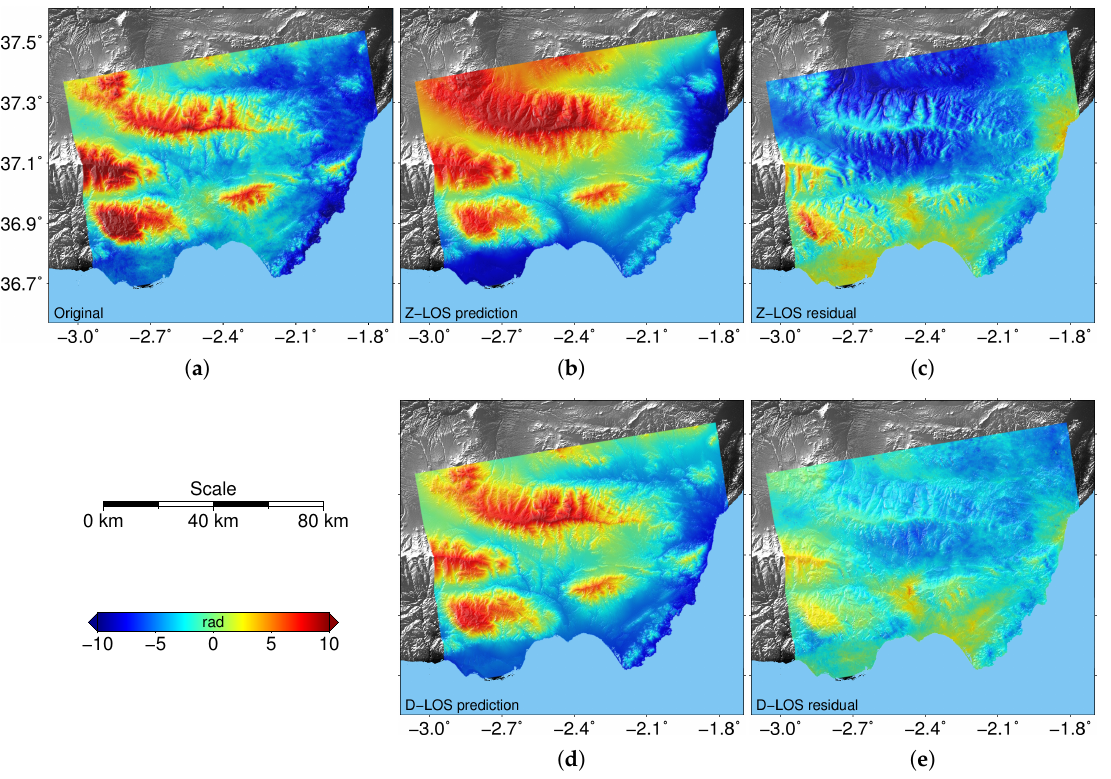
Figure 13. 20171031–20171124 (Ifg11) case study of APS compensation in Almería. ( a ) The original interferogram. ( b , c ) The Z-LOS predicted APS and corrected interferogram with Z-LOS method. ( d , e ) The D-LOS predicted APS and corrected interferogram with the D-LOS method.